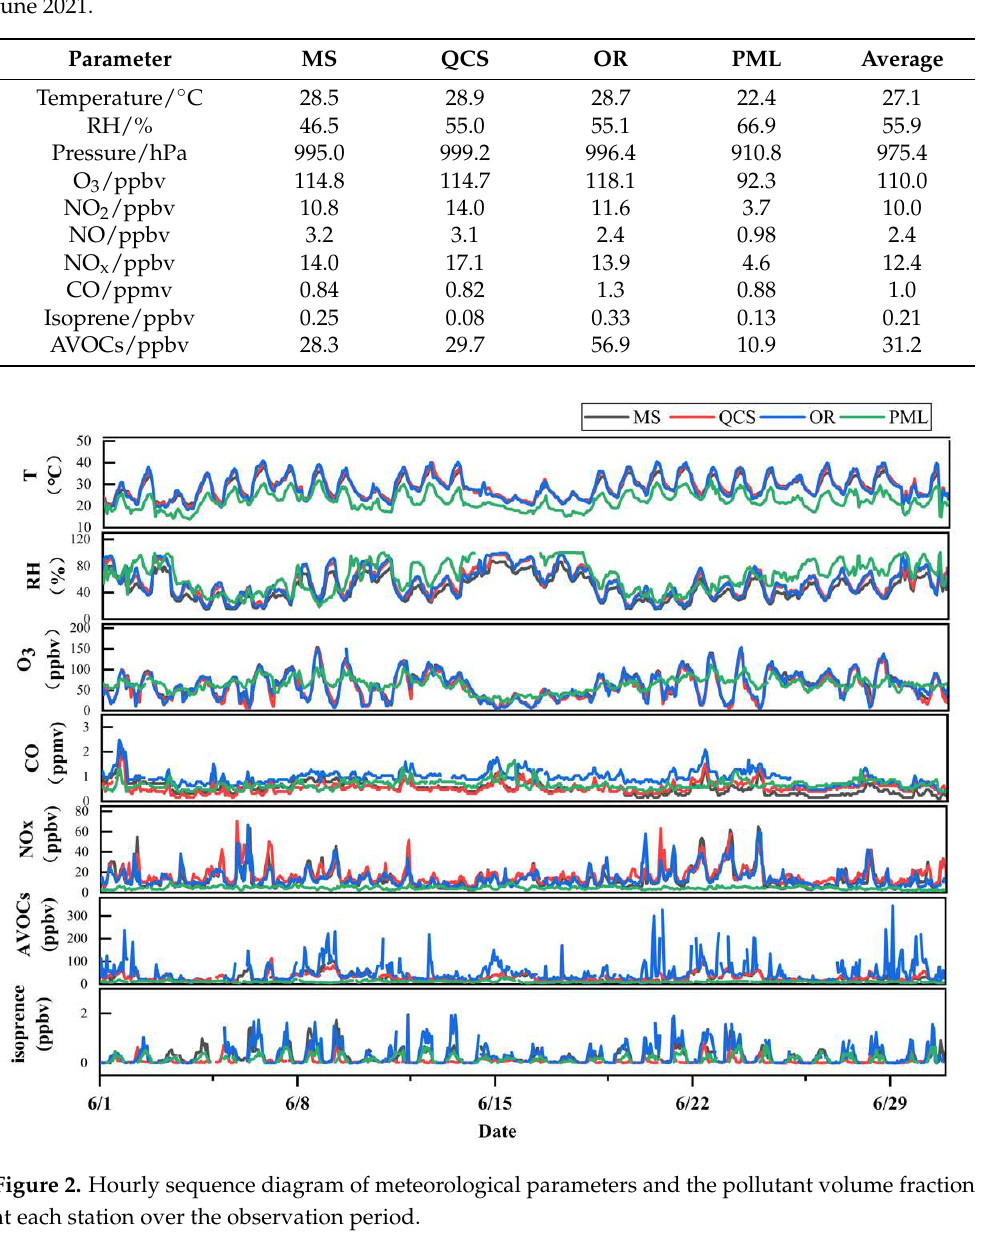
Table 1. Mean values of meteorological parameters and pollutant volume fractions at each site in June 2021.